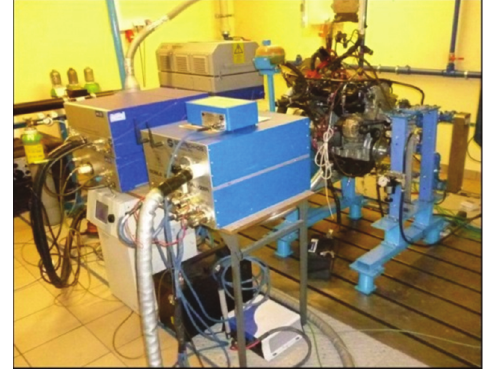
Fig. 3. Dynamometer test bench with the measuring apparatus